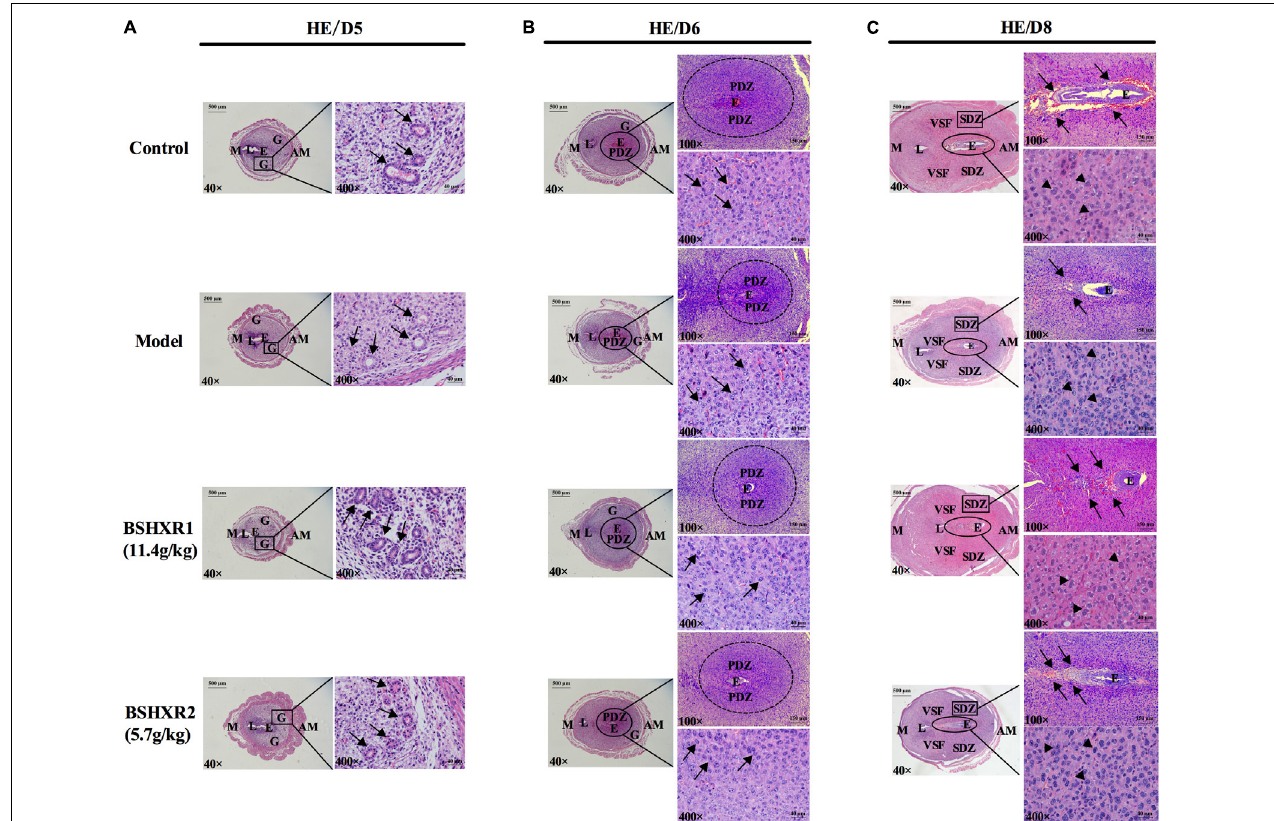
FIGURE 5 | Morphology analysis of uterine section on D5, D6, and D8. The right pictures are the higher magnification images of the black boxes or ellipses on the left. (A) The development of glands on D5. Arrows indicate glands. (B) Formation of PDZ on D6. Arrows indicate decidual cells. (C) Formation of SDZ and surrounding blood vessel of embryo on D8. Arrows indicate blood vessels and arrowheads indicate decidual cells. E, embryo; L, lumen; G, gland; PDZ, primary decidual zone; SDZ, secondary decidual zone; M, mesometrial; AM, anti-mesometrial; VSF, vascular sinus folding. Original magnifications and scale bar were shown in